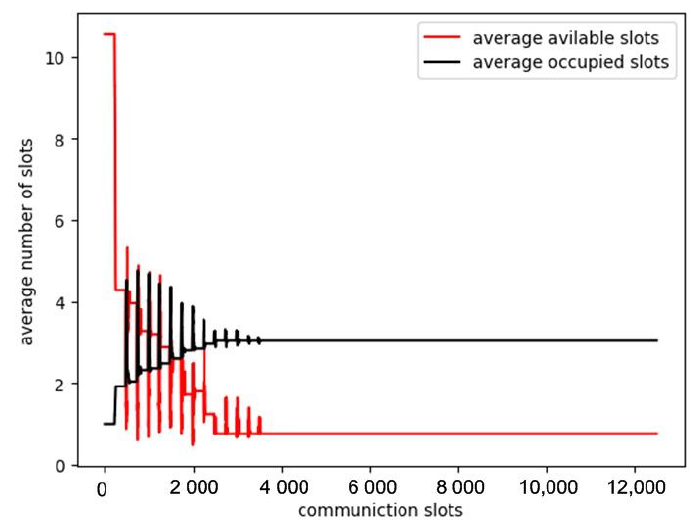
Figure 9. The average number of slots occupied by nodes over time. For each node, its available slots denote the communication slots not occupied by any of the node’s first-order or second-order neighbors. The average available slots represent the average number of all nodes’ available slots, and the average occupied slots denote the average number of available slots occupied by nodes.